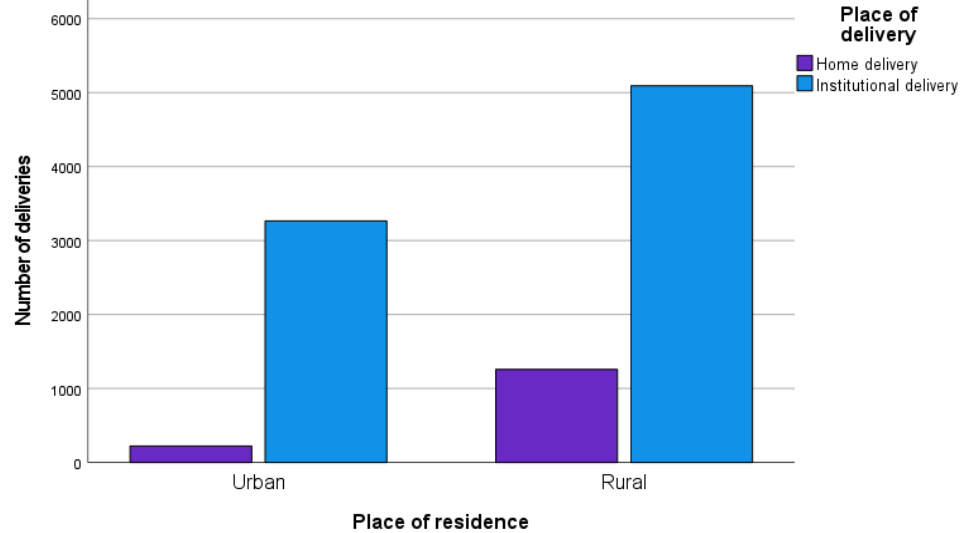
Figure 2. Delivery pattern by place of residence. The comparison of women with and without institutional delivery revealed that the woman’s age, place of residence, parental education, number of children, wealth index, contraception use decision, ANC visits, healthcare facility, and blood pressure differed significantly between groups. Conversely, religion, working status, and anemia did not show significant differences between groups (Table 2). The value of VIF between the independent variables was less than 1.5, indicating that no specific variables were highly collinear in the prediction models